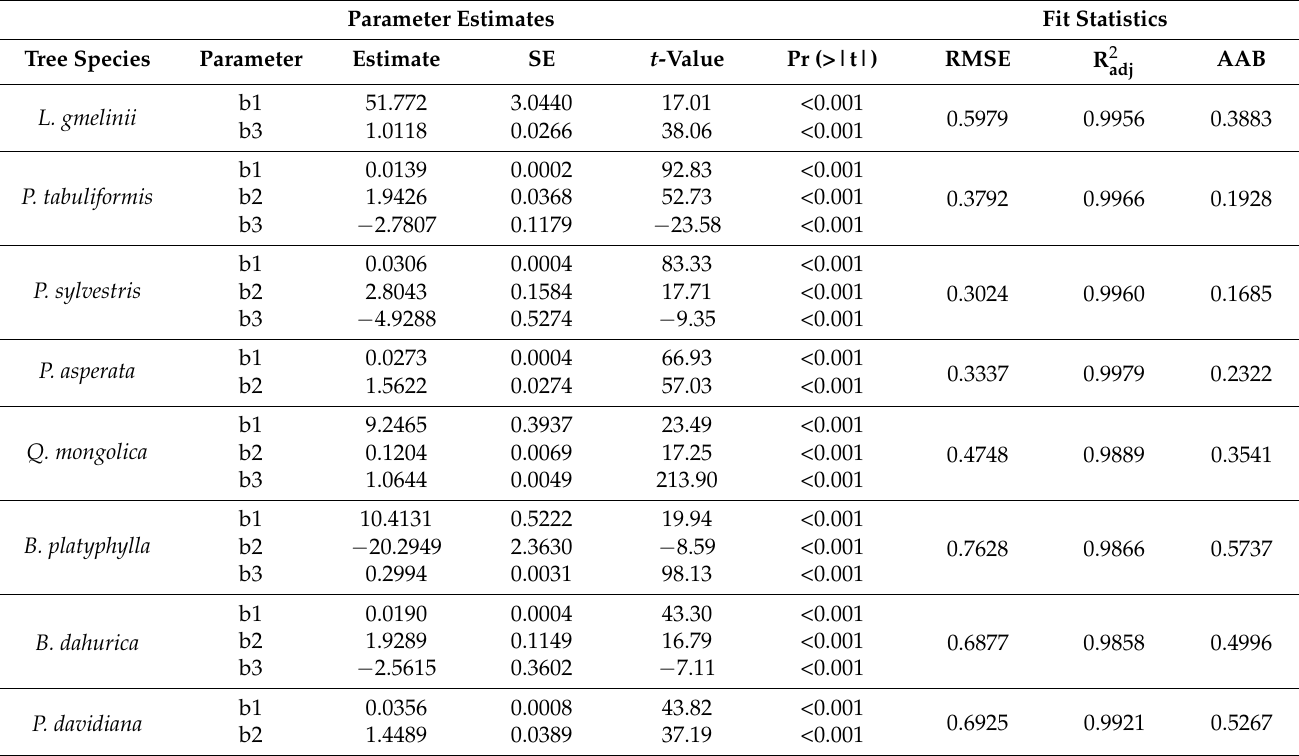
Table 4. Estimated parameters for the GADA models and goodness-of-fit statistics: RMSE = root mean square error (m); R 2 = adjusted R 2 ; AAB = average absolute bias (m). adj